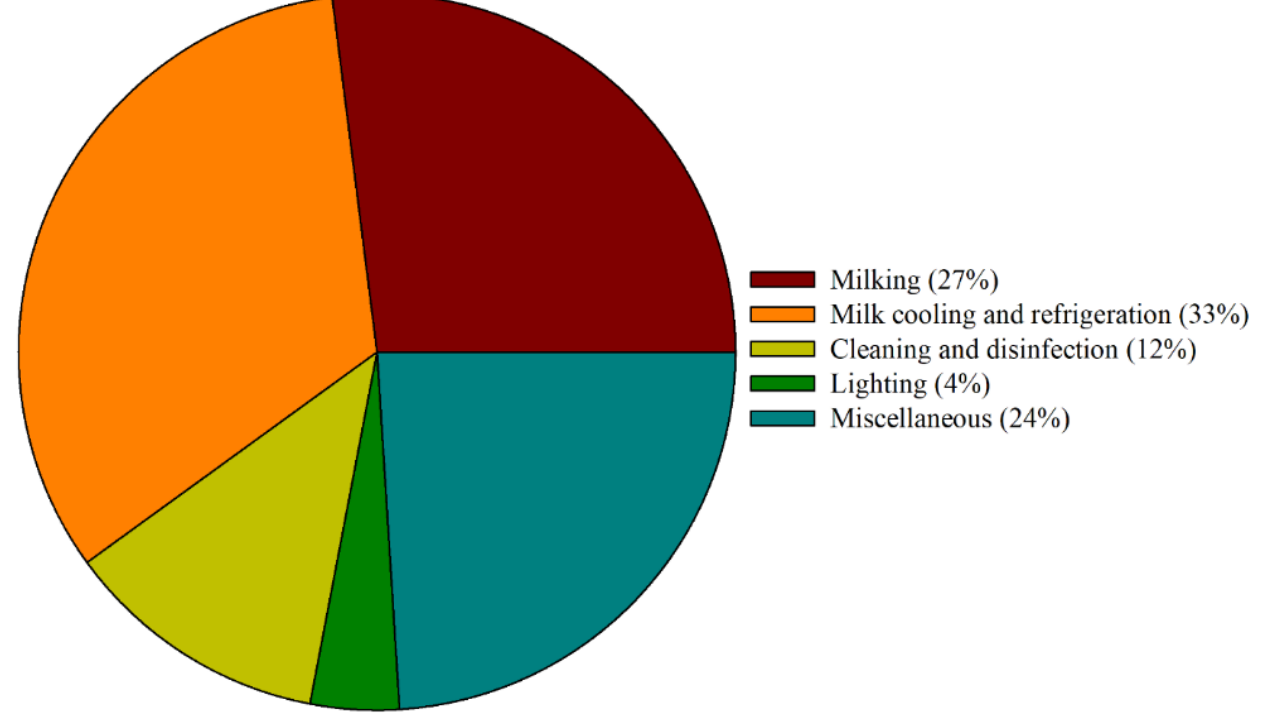
Figure 2. Average electrical energy consumption in Brazilian dairy farm operations.